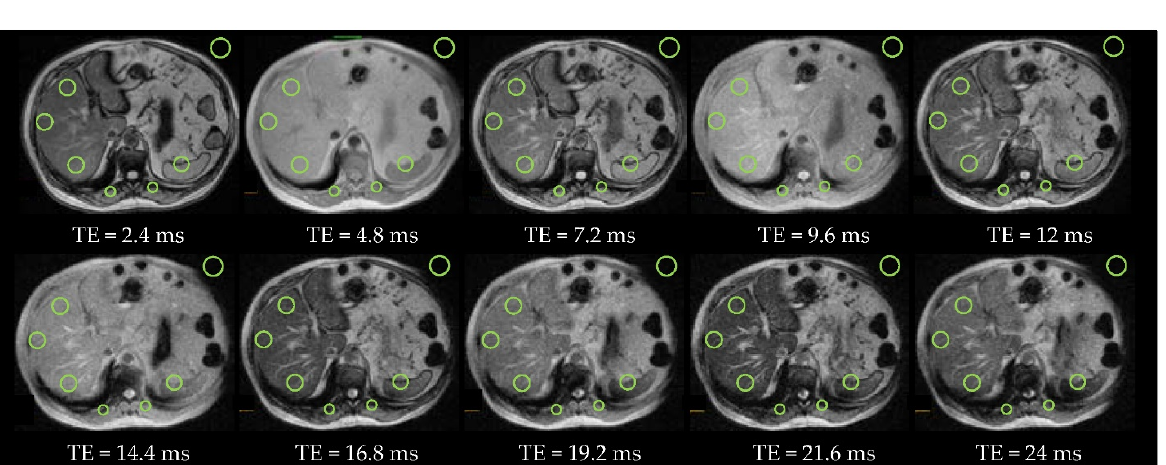
Figure 8. Patient #3 with absence of iron overload and steatosis at 3T ( T2 * = 16.1 ms and LIC = 19 µmol/g). There are 12 echoes with a duration of 1.2 ms each one. The OOP images are with TE = 1.2 ms, 3.6 ms, 6 ms, 8.4 ms, 10.8 ms, and 15.6 ms and IP images are with TE = 2.4 ms, 4.8 ms, 7.2 ms, 9.6 ms, 12 ms, and 14.4 ms. There are 3 ROis in the liver, 2 ROIs in paravertebral muscles, 1 ROI in the spleen and 1 ROI of background noise. Figure 9 shows the T2_Multi-echo sequence with 10 echoes, acquired at 1.5T, from a subject (patient #5) with severe iron overload.